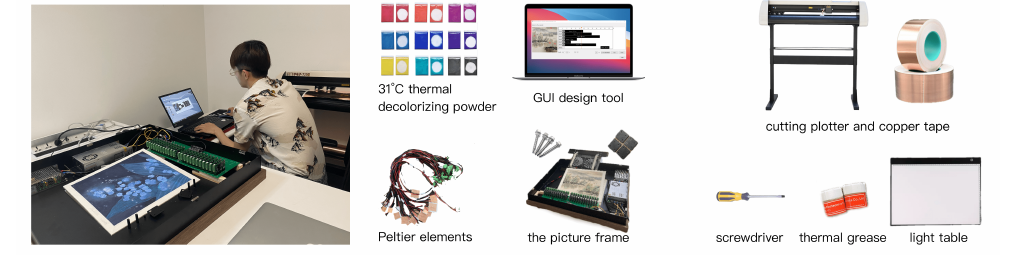
Figure 11. Experimental site and